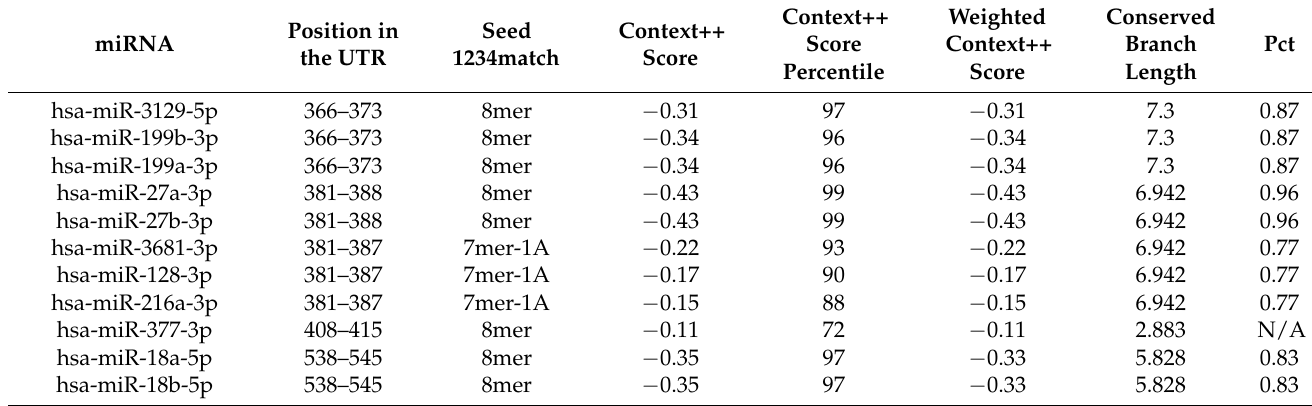
Table 1. Ten miRNAs with the strongest association with NEDD4-1 according to Targetscan database. Position miRNA